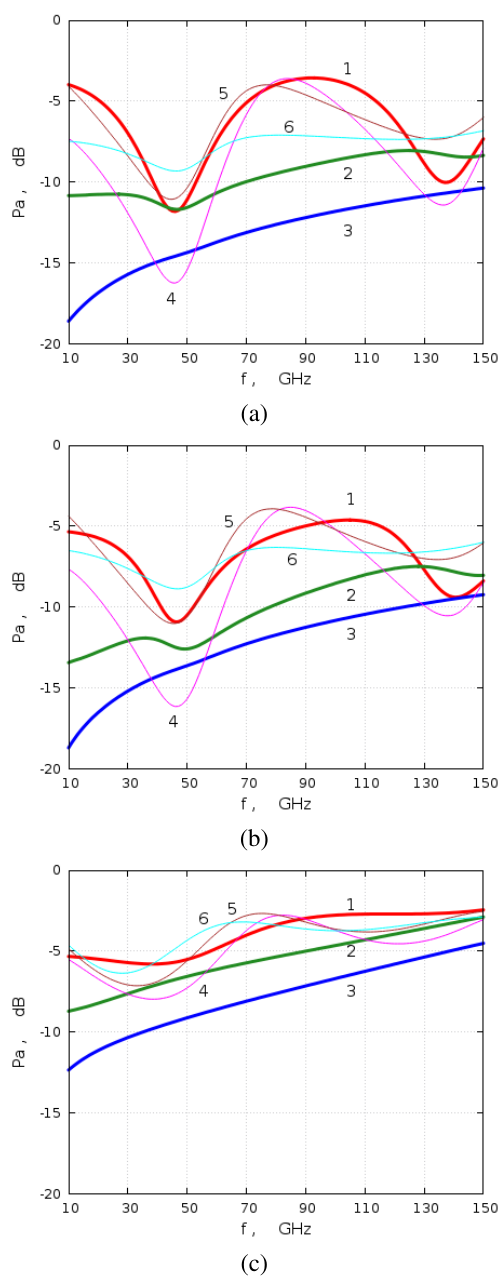
Figure 4: Absorption in a slab with (a) strip-like, (b) wire- like, and (c) fin-like photo-excited gratings for MM waves of E (curves 1 to 3) and H (curves 4 to 6) polarization at (a) P L = 0 . 1 , 1 , 10 kW/cm 2 , (b) P L = 1 , 10 , 100 kW/cm 2 , and (c) P L = 0 . 1 , 0 . 3 , 1 kW/cm 2 , respectively (curve 7 shows the dark-state